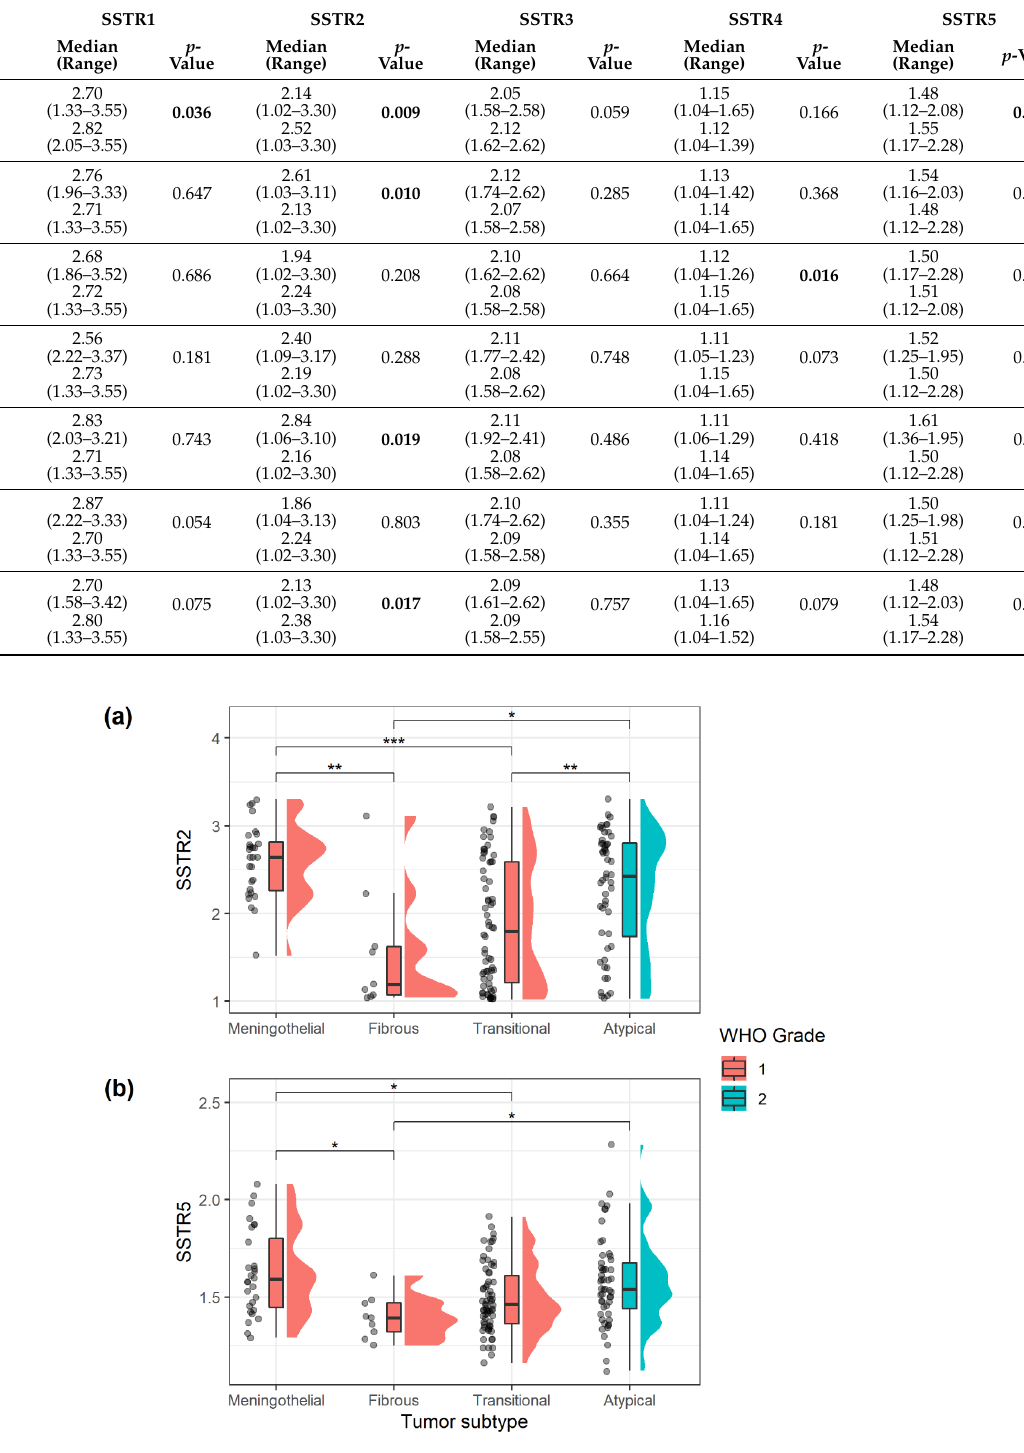
Figure 3. SSTRs expression related to tumor subtypes according to the digital scoring. Significant associations are marked: * p < 0.05, ** p < 0.01 and *** p < 0.001. Data are presented as boxplot (25th percentile, median and 75th percentile, whiskers 1.5 IQR), distribution and datapoints: ( a ) SSTR2 expression related to subtypes; ( b ) SSTR5 expression related to subtypes. The SSTRs showed variable specificity for meningiomas (Figure 4), and SSTR2 ap- peared to be the most specific. Two tissue samples of each of the following differential diagnoses were tested for SSTRs expression: neurofibroma, schwannoma, solitary fibrous tumor/hemangiopericytoma and hemangioblastoma. SSTR1 and SSTR5 presented the same immunoreactivity, as one case of neurofibroma and one case of schwannoma were negative and the other tumor samples were positive. Regarding SSTR2, one case of neu- rofibroma and all cases of schwannoma, solitary fibrous tumor/hemangiopericytoma and hemangioblastoma were negative, while the other case of neurofibroma was positive. SSTR3 were immunoreactive in all tumors, whereas SSTR4 were negative in all differential diagnoses. Normal meningeal tissue was not immunoreactive for SSTR4 and SSTR5. For SSTR1 and SSTR2, eight specimens (80%) were negative, while two samples were weakly posi- tive or difficult to evaluate. In contrast, nine specimens (90%) expressed immunoreactivity for SSTR3.